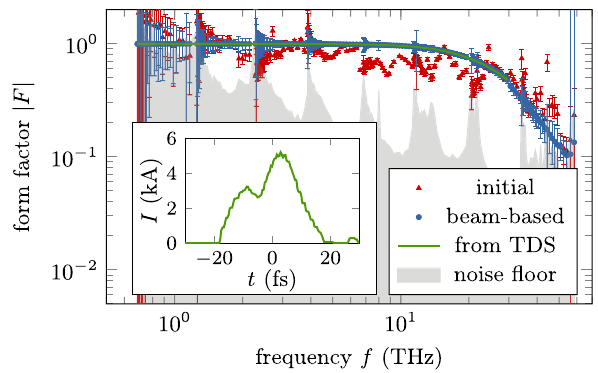
FIG. 6. Simulated signal of the overall system for an infinitely short electron bunch (bright and dark red triangles). The four different gratings for the two different sets (brighter and darker color) are clearly visible. The bright and dark blue dots show the final calibration after the beam-based correction.